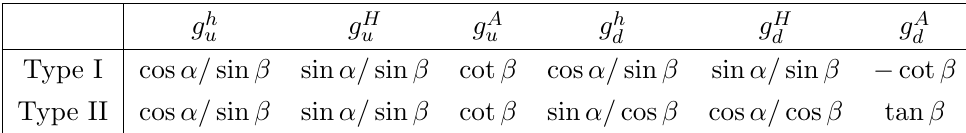
Table 11 . The Higgs-quark couplings g (cid:30) IV we refer to the comment in the text.